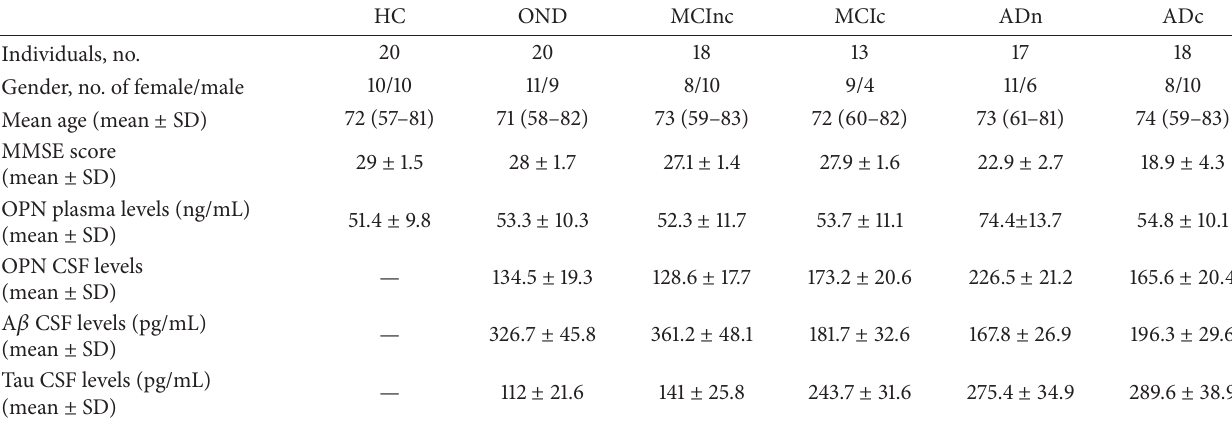
Table 1: Clinical details and laboratory findings of HC, OND, MCI, and AD